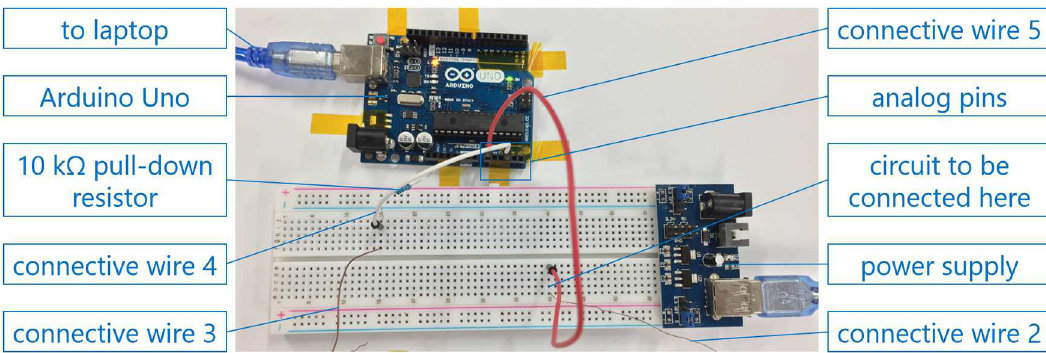
Fig. 3. A part of the top view of the bimetallic ammeter. It shows how components on the popsicle stick base are connected to relevant pins in the Arduino Uno microcontroller. Note that the connective wires 2 and 3 are linked to parts in Figure